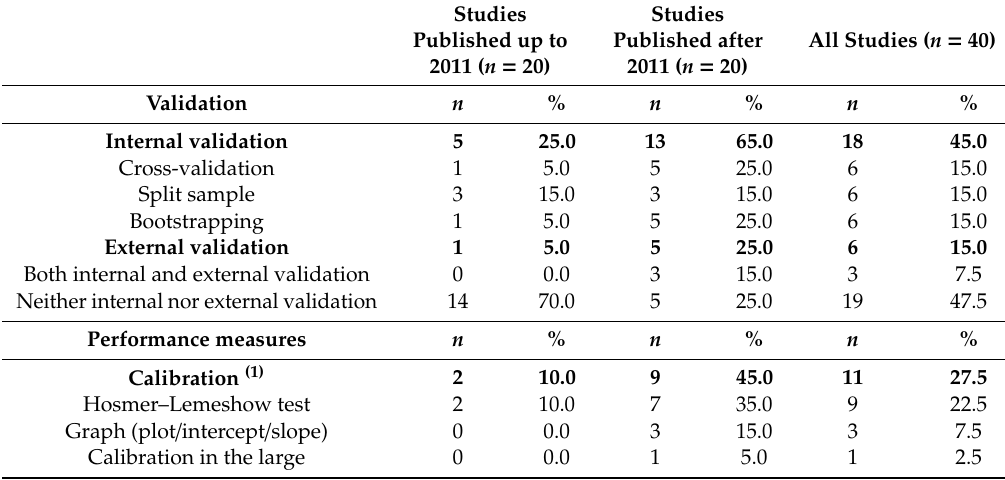
Table 4. Absolute ( n ) and relative frequencies (%) of methods used when evaluating risk prediction models for melanoma regarding the methodological type of validation and the type of measures describing model performance ( n = 40 studies)